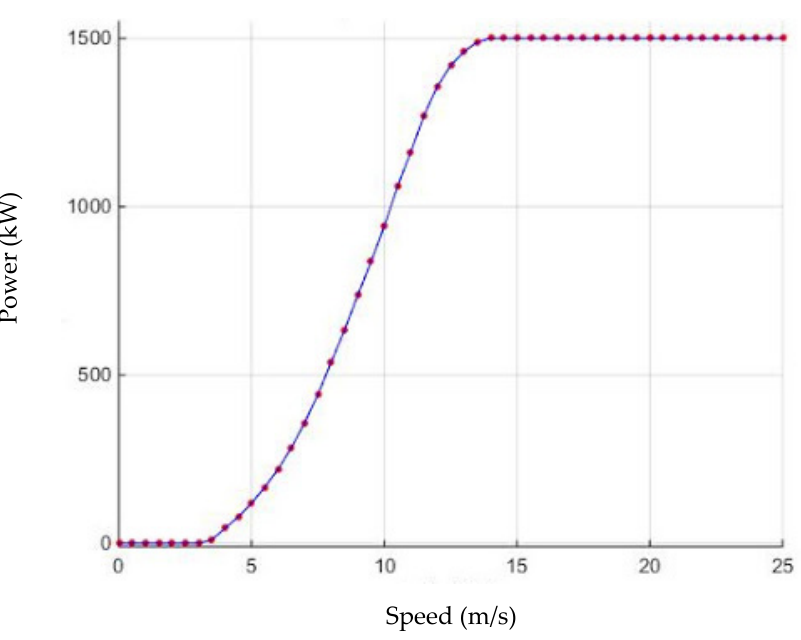
Figure 2. Energy produced by a wind turbine .